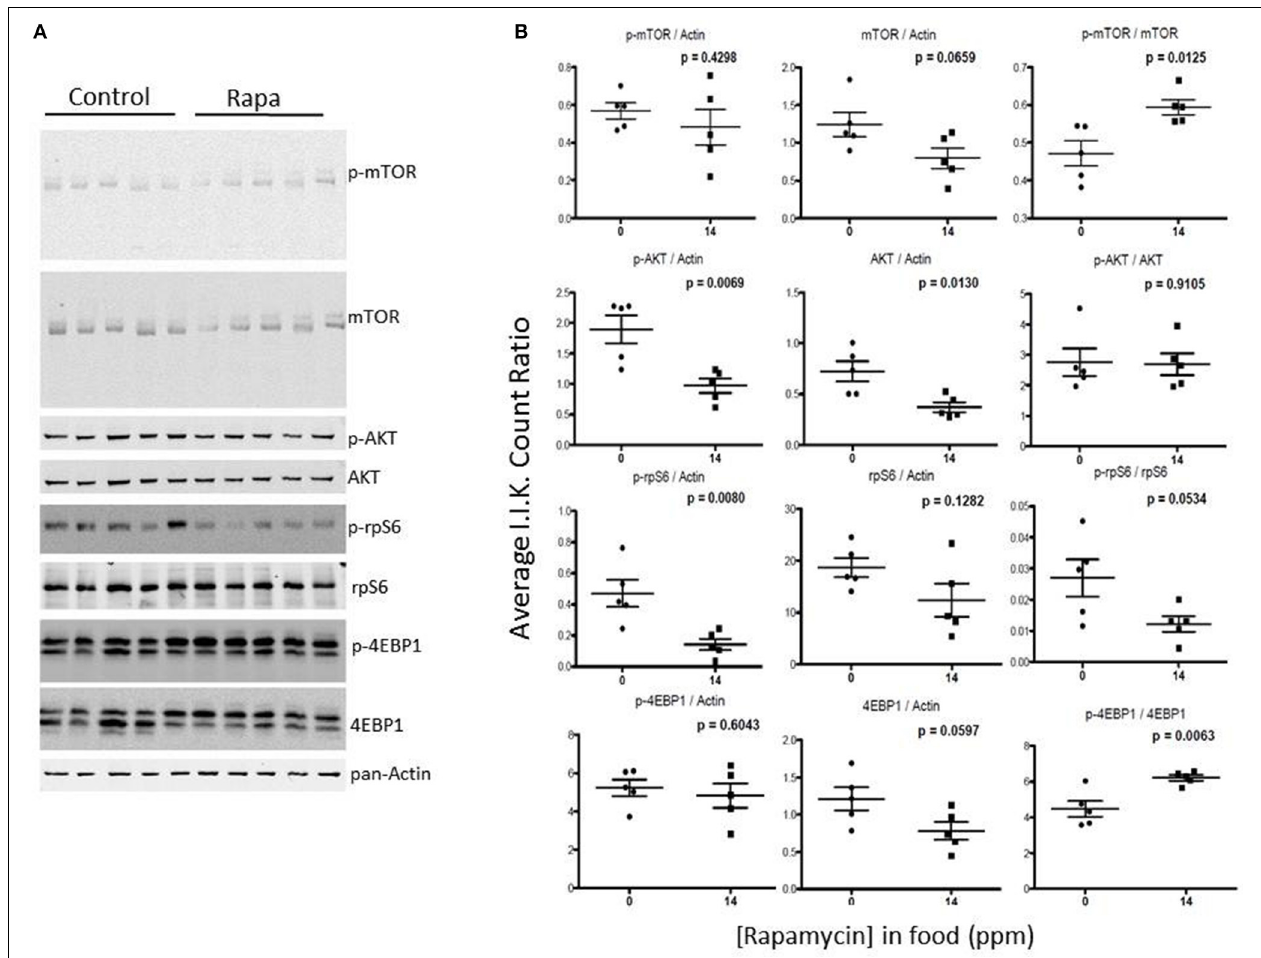
FIGURE 9 | The phosphorylation state of downstream mTOR pathway markers changed significantly in visceral fat lysates from rapamycin-treated females. Measuring protein content of several mTOR pathway markers analyzed from visceral fat lysates taken from 25 month rapamycin-fed and control female mice via immunoblot